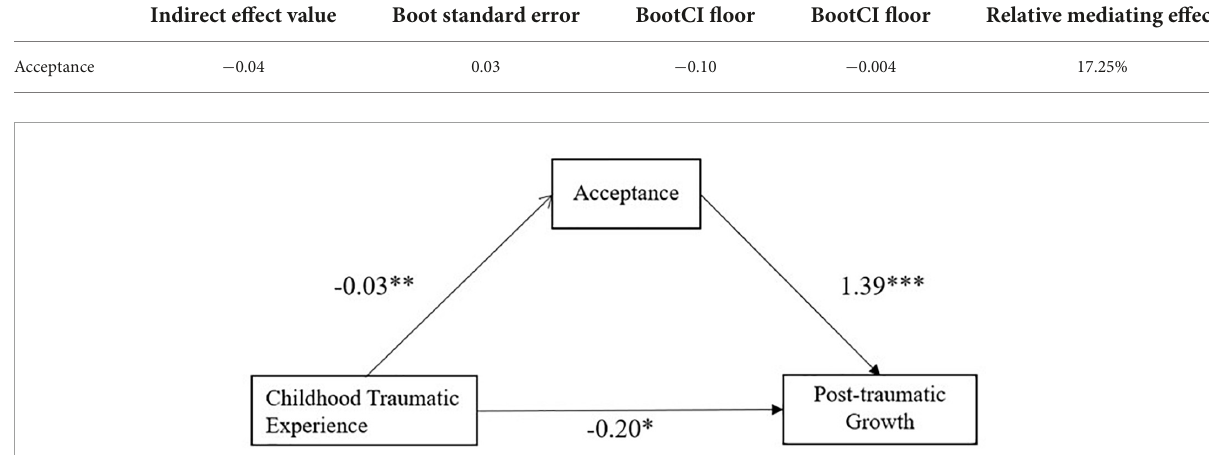
TABLE 5 Mediating effect analysis of acceptance.